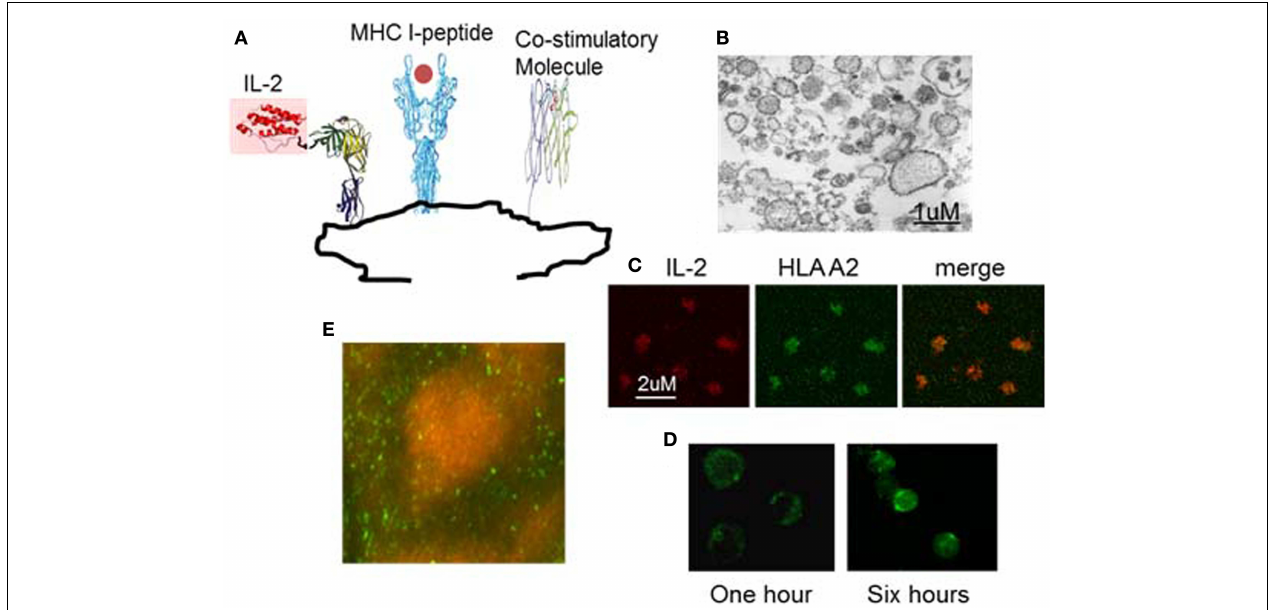
(green). (D) Confocal microscopy shows interaction of nanoAPC (green) with T lymphocytes after 1 and 6h in vitro . After 6h, nanoAPCs are internalized into T cells. (E) Distribution of nanoAPC (green) prepared from mouse dendritic cells inT lymphocyte areas of mouse lymph node 48h after i.v. injection. B cells were stained by B220